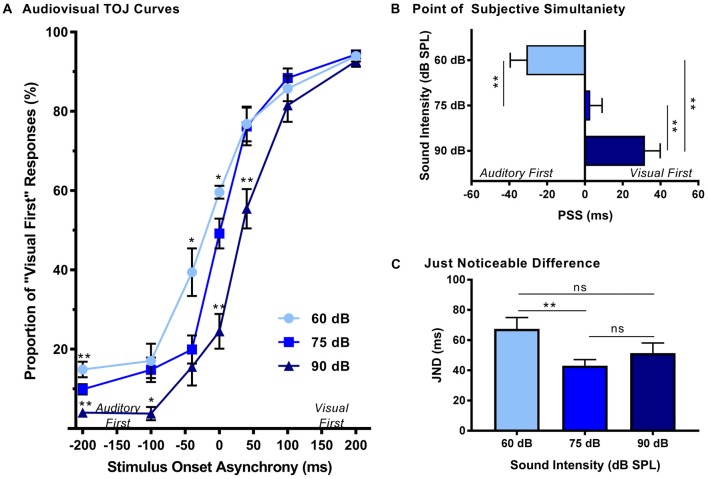
Effect of sound intensity on audiovisual temporal order perception. (A) Behavioral performance was plotted as the proportion of responses the rat perceived as “visual-first” (i.e., right feeder trough) for test days completed at 60 dB, 75 dB and 90 dB sound pressure level (SPL). A right-ward shift in the TOJ curve was observed as the intensity of the auditory stimulus increased. For example, at 0 ms stimulus onset asynchrony (SOA) there was an increase in “visual-first” responses at 60 dB SPL when compared to 75 dB SPL (*p < 0.01), and a significant decrease in “visual-first” responses at 90 dB SPL when compared to 75 dB SPL (**p < 0.001). (B) The point of subjective simultaneity (PSS) and (C) the just noticeable difference (JND) were derived from the TOJ task. For PSS, a significant difference was observed between all sound intensities (**p < 0.001), demonstrating a right-ward shift from “auditory-first” responses to “visual-first” responses as the sound intensity increased. For JND, a significance difference was only observed at the lowest sound intensity (i.e., 60 dB SPL), resulting in an increased window of integration (**p < 0.01, ns = not significant). Results are displayed as mean ± standard error of the mean (SEM), n = 10.